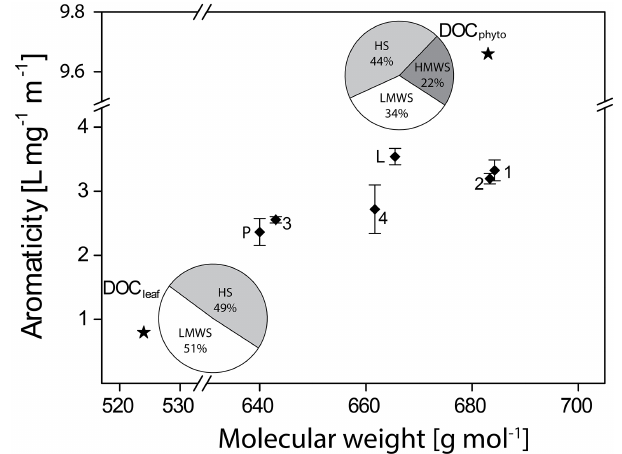
Fig. 2. Humic substances diagram as shown after Huber et al. (2011) with aromaticity (SAC/OC ratio inLmg − 1 m − 1 ) plotted against molecular weight (in gmol − 1 ) of the single phytoplankton (P) and leachate (L) incubation and the mixed treatments (1, 2, 3, 4) at the end of the experiment ( t 12 , rhombi) and of the initial DOC phyto and DOC leaf added as DOC sources to the treatments (stars). The pie charts illustrate the chemical composition of both DOC phyto and DOC leaf sources as revealed by liquid chromatography–organic car- bon detection (LC-OCD), a method that distinguishes between low- molecular-weight substances (LMWS), humic or humic-like sub- stances (HS) including building blocks, and high-molecular-weight substances